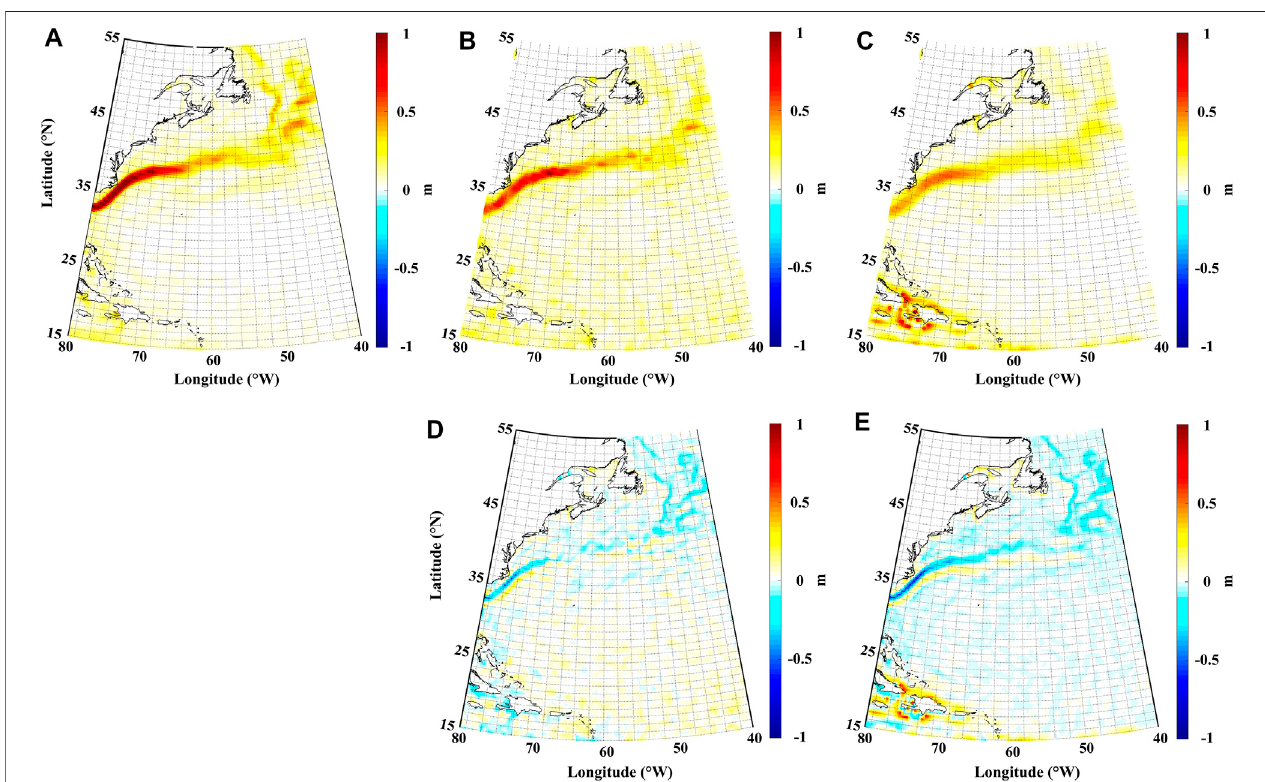
FIGURE 7 | Top panel: Estimated geostrophic currents deduced from (A) Synthetic_Current, (B) estimated MDT, and (C) Gaussian fi ltered MDT are illustrated, respectively. Bottom panel: mis fi ts between deduced geostrophic current against the Synthetic_Current, where the mis fi ts from (D) estimated MDT (DIR6) and (E) Gaussian fi ltered MDT are illustrated, respectively.